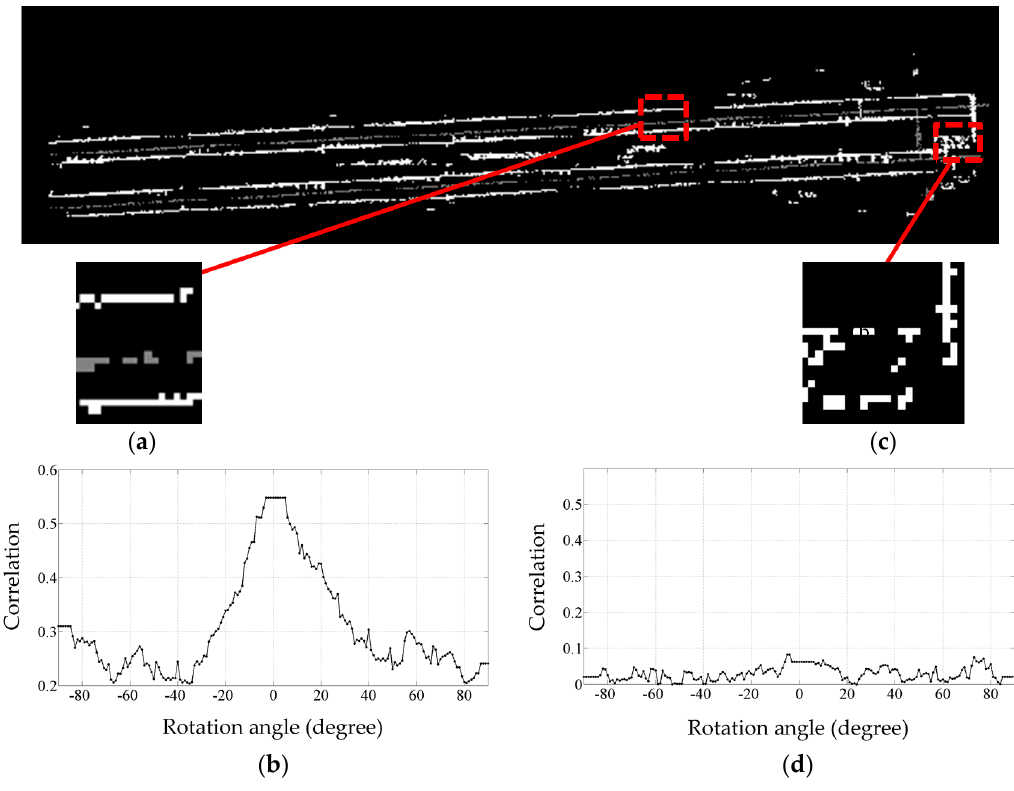
Figure 8. The results of template matching in two different parts of the dataset with the template rotated from − 90° to +89°: ( a ) A sample part that contains a piece of rail track; ( b ) Its correlation plot indicating a distinctive peak at 0°; ( c ) A sample incorrect rail track recognition; ( d ) Its correlation plot showing no peaks for any rotated version of the template.